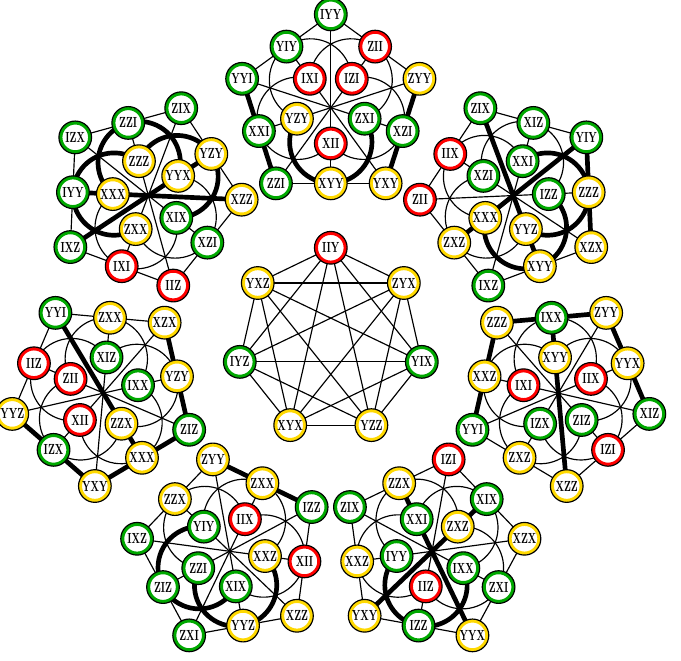
Figure 9. A ‘Conwell’ heptad of doilies in the three-qubit W ( 5,2 ) . Following our convention, different types of observables are distinguished by different colors and negative lines are shown in